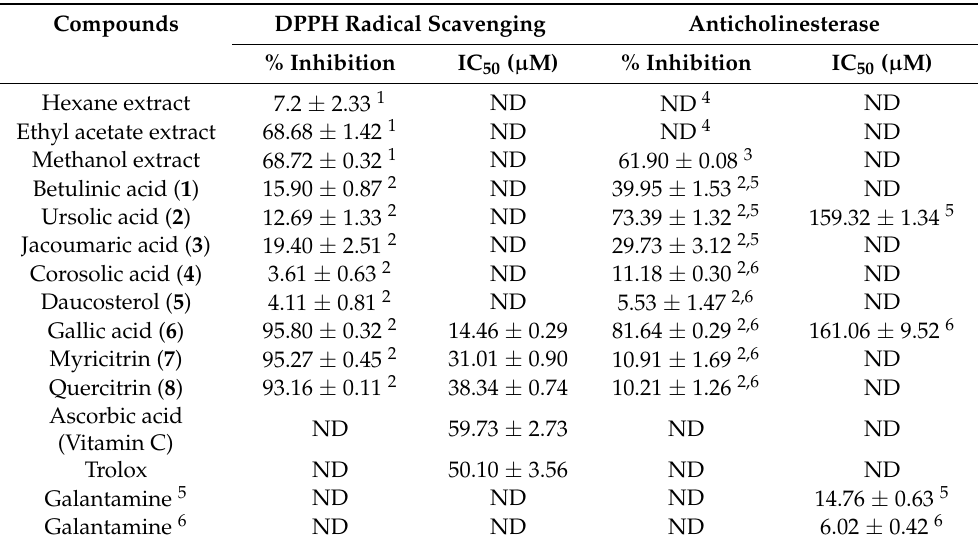
Table 1. DPPH radical scavenging and anticholinesterase activities of the methanol extract and isolated